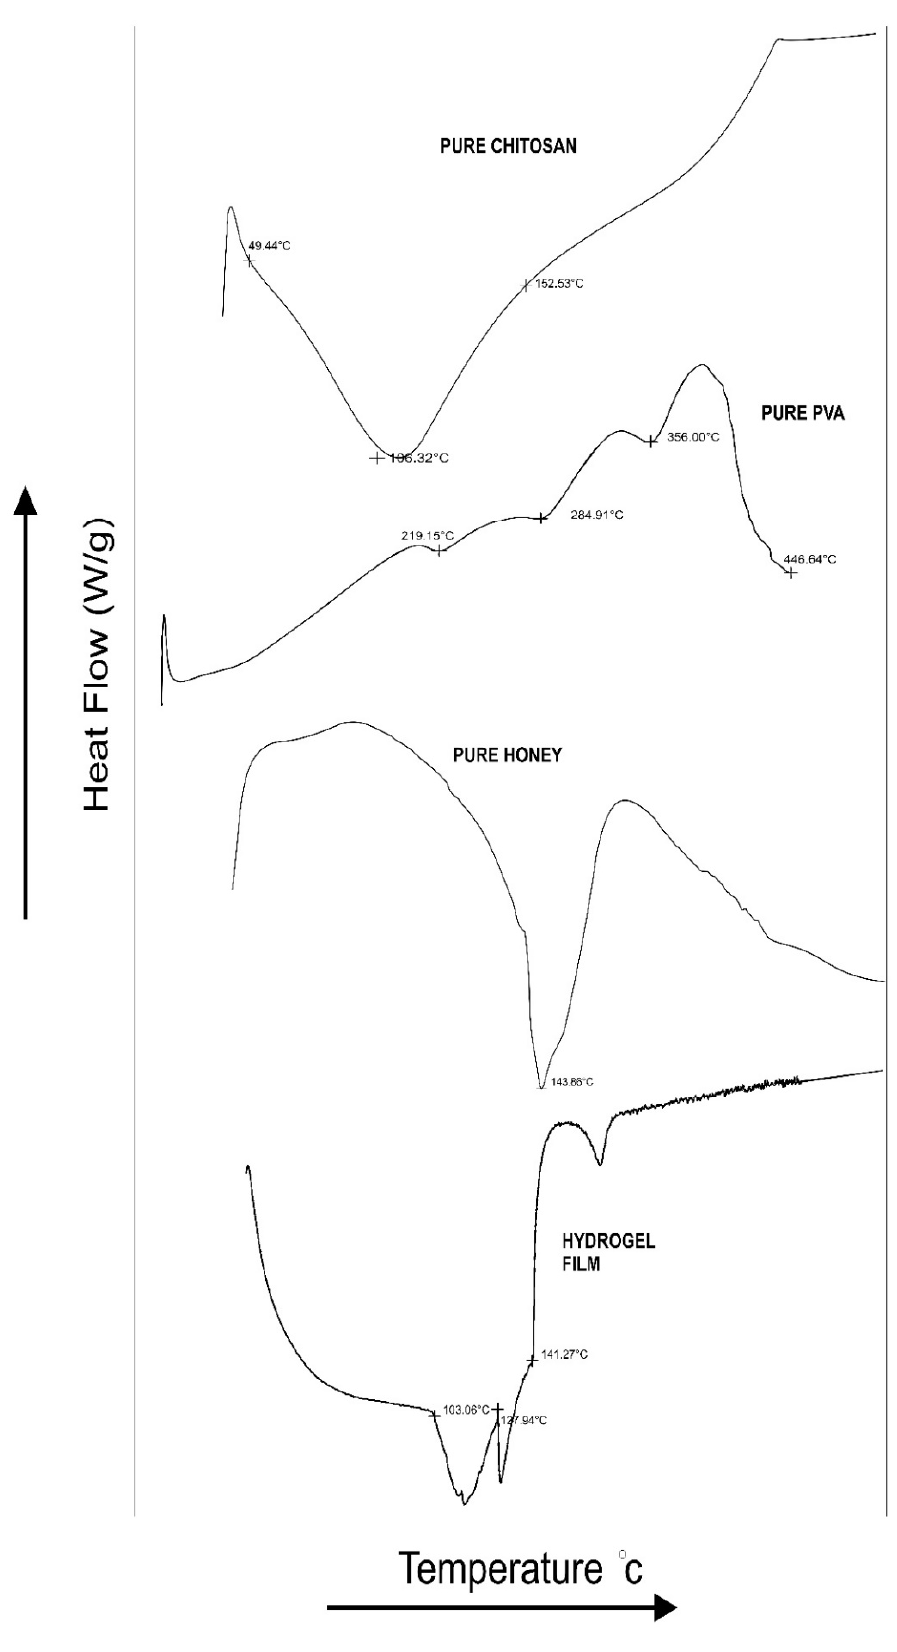
Figure 5. DSC thermograms of Chitosan, PVA, Honey, and Hydrogel film F5 batches.